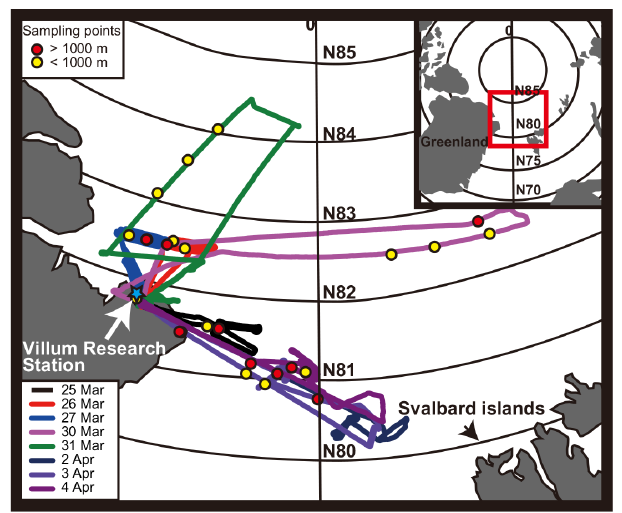
Figure 1. Flight tracks and locations of the TEM samplings dur- ing the PAMARCMiP 2018. The blue star indicates the Villum Re- search Station in Greenland. The yellow points indicate the sam- pling locations below 1000m. The red points indicate those above 1000m. The sampling points are the midpoints of the sampling time: 19min for all samples except during the 3 and 4 April flights, which had a sampling time of